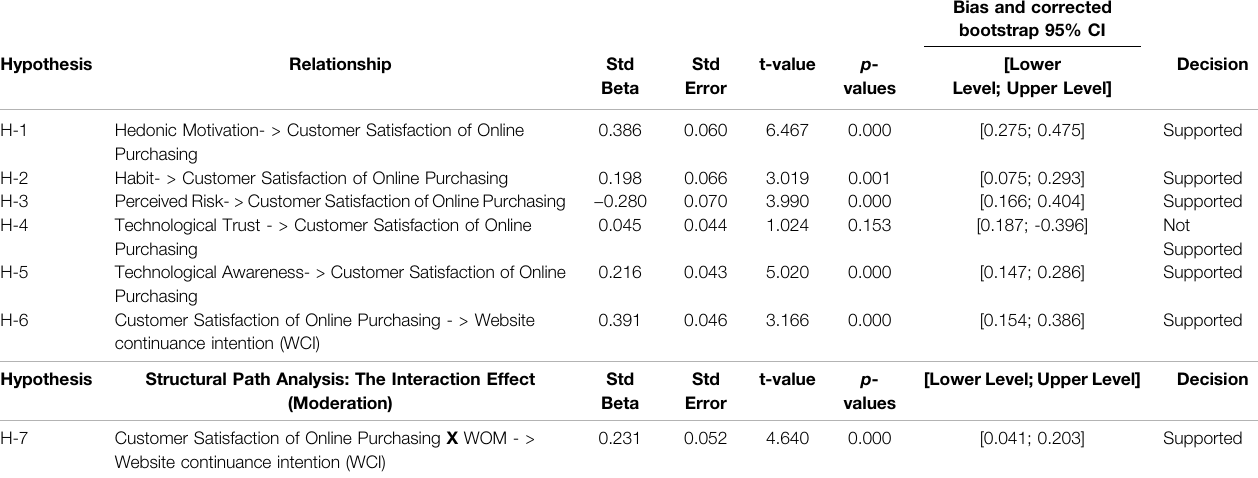
TABLE 4 | Structural path analysis: direct effect and interaction